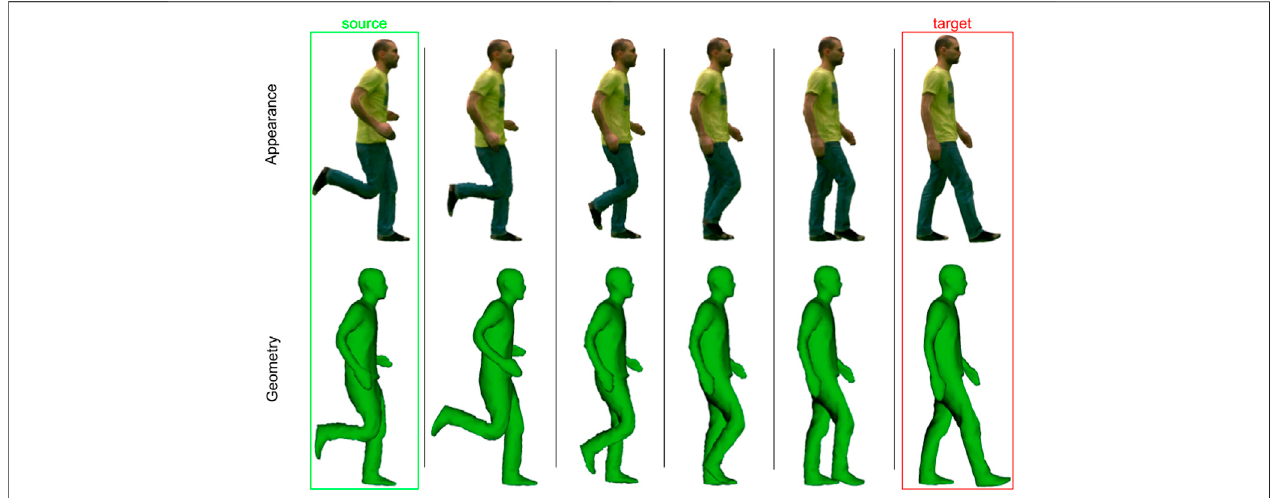
FIGURE6| Latentspaceinterpolation,twoframeswithdistinctmotionsareselected,ontheleftsurroundedwithagreenboxisthesource,ontherightsurrounded with a red box is the target, in between is the interpolated results for 4D shape and appearance.